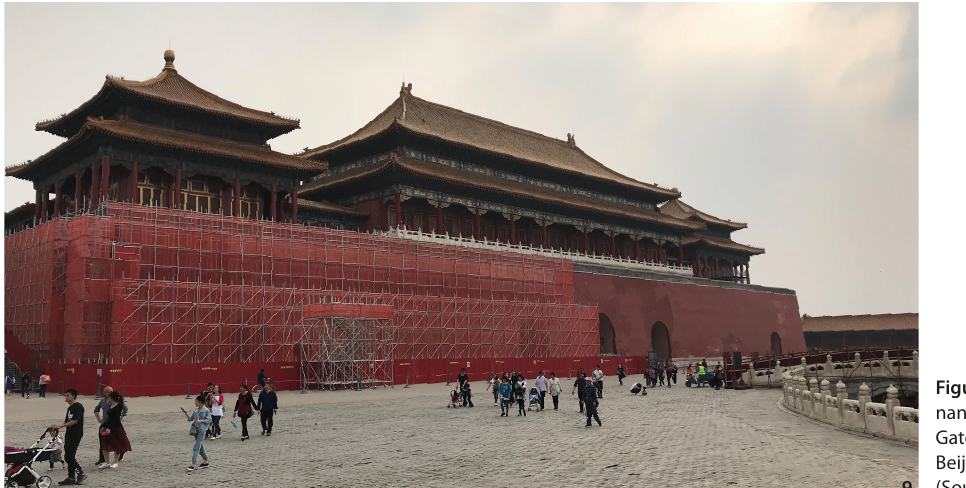
Figure 9 Lime plaster mainte- nance for Wu Men (Meridian Gate) of the Palace Museum in Beijing during the summer 2018 (Source: the author).